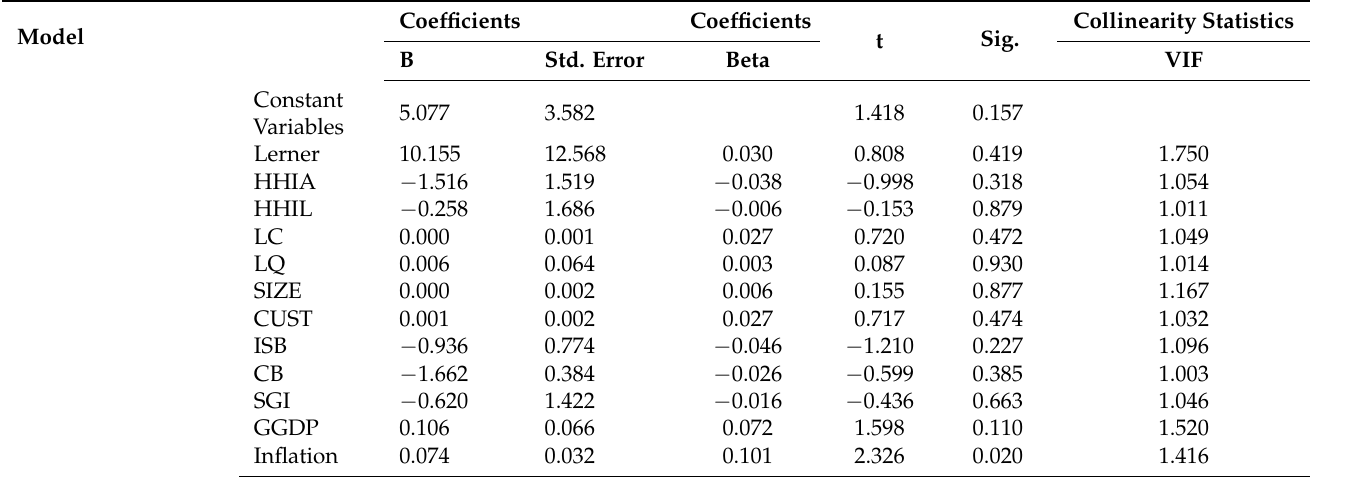
Table 4. Variance inflation factors